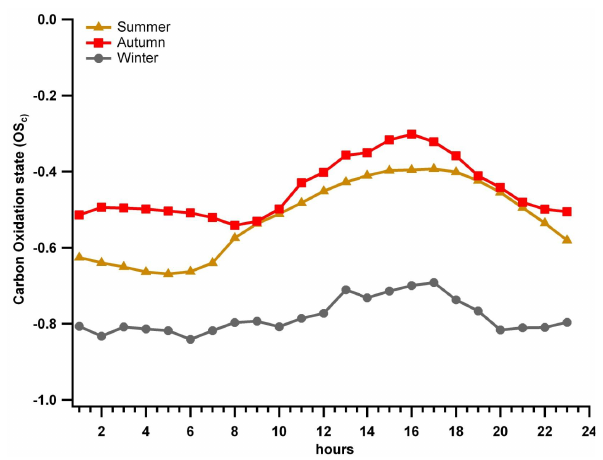
Fig. 6. Diurnal cycle of the carbon oxidation state for each season.